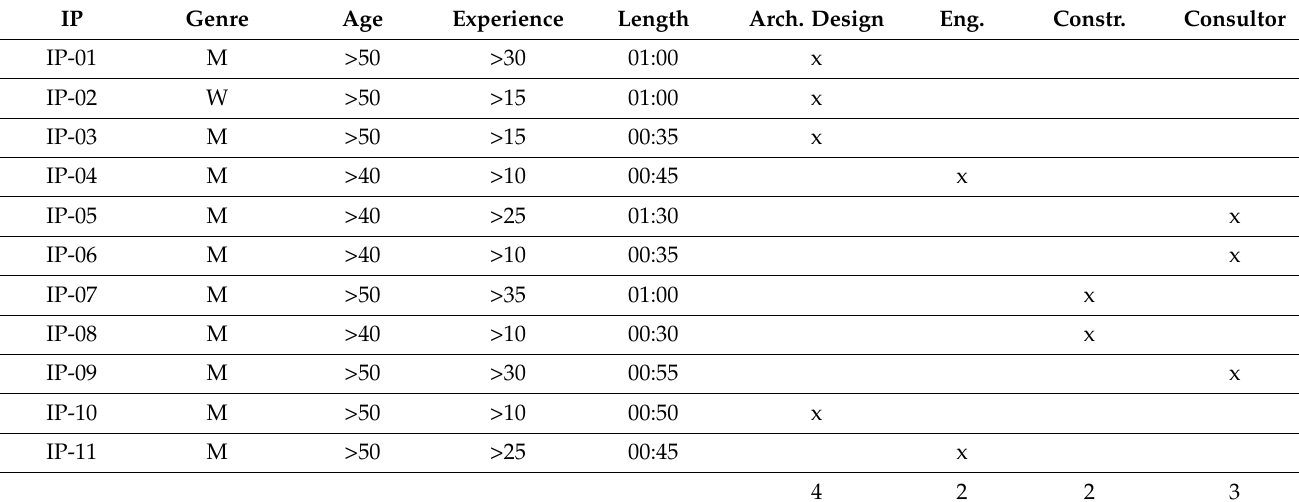
Table 2. Interview Partners